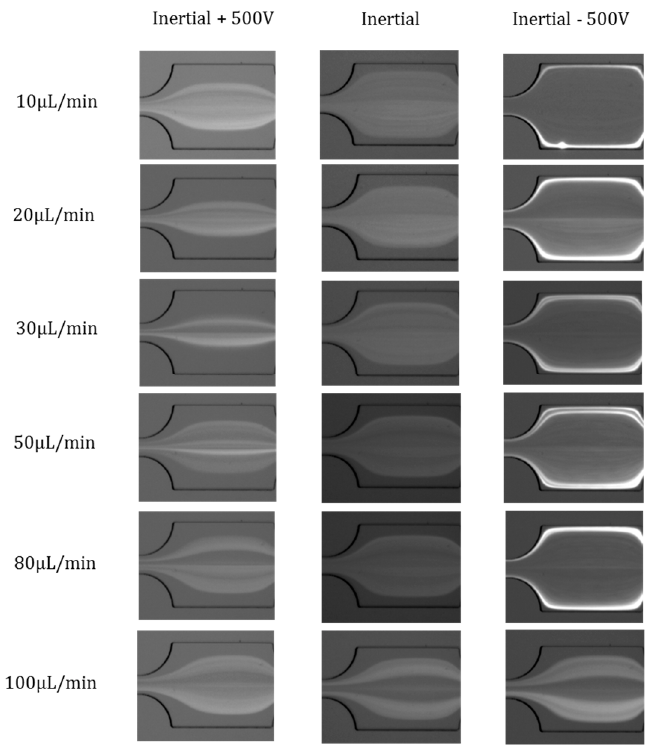
Figure 4. Effects of flow rates on particle distribution in Inertial +500 V, pure Inertial, and Inertial − 500 V cases.